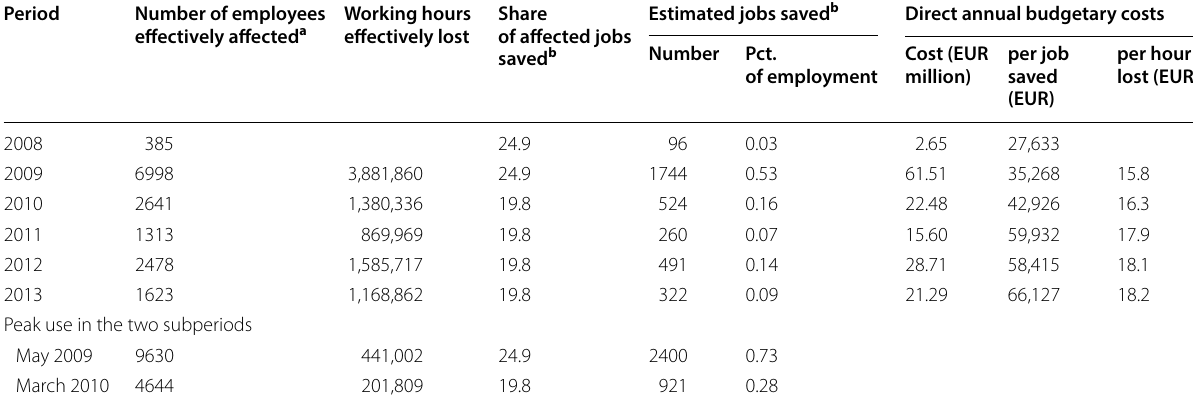
Table 4 Use of STW and its